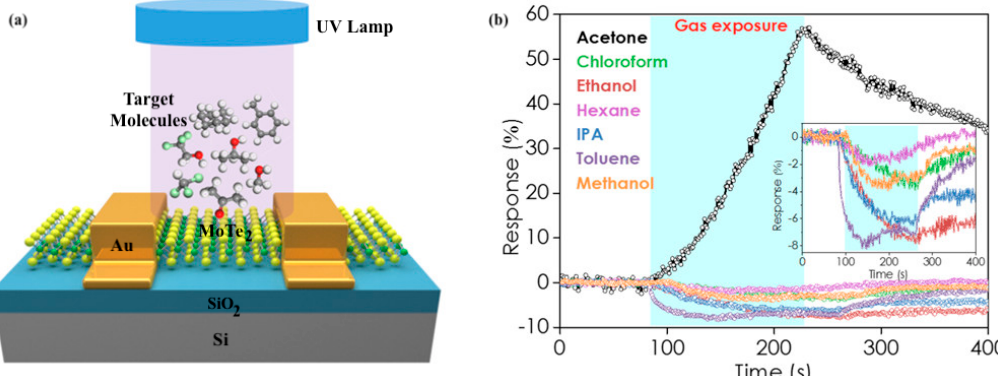
Figure 10. ( a ) Schematic diagram of MoTe 2 FET sensing setup; ( b ) Sensing response of the MoTe 2 FET toward seven different VOCs, including acetone, chloroform, ethanol, hexane, isopropanol, toluene, and methanol, all at 100 ppm. Measurements were taken under UV light. Only acetone induced a positive response (increase in conductance upon gas exposure). Reprinted with permission from [114]. Copyright (2018), American Chemical Society.